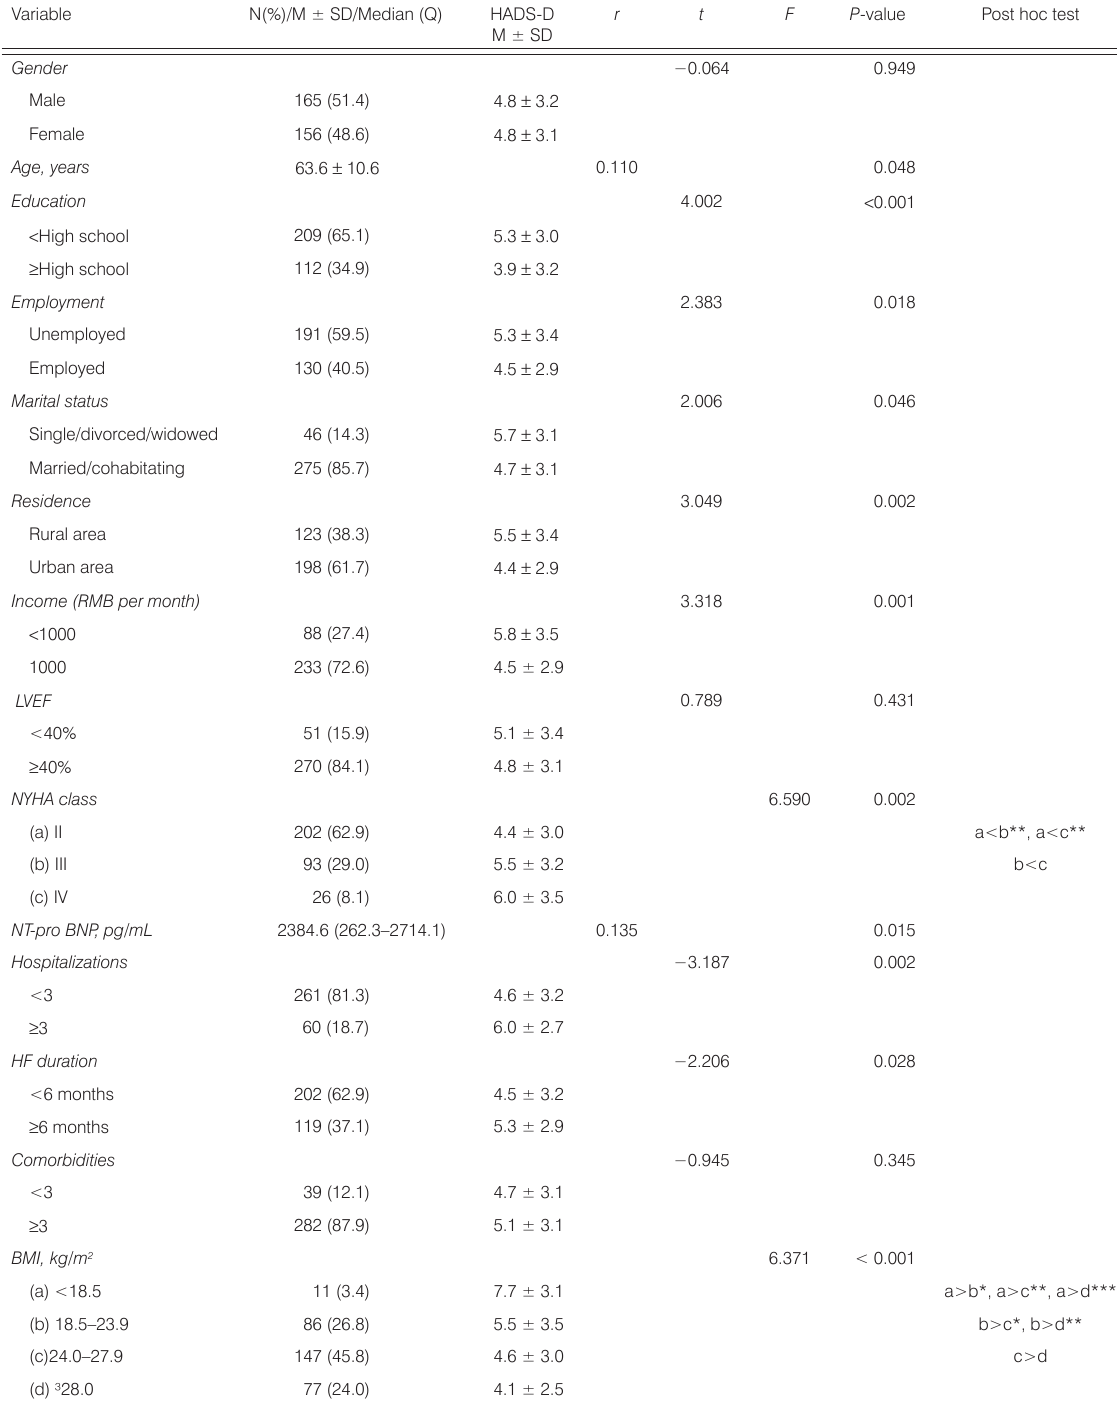
Table 1. Comparison of HADS-D score by sample